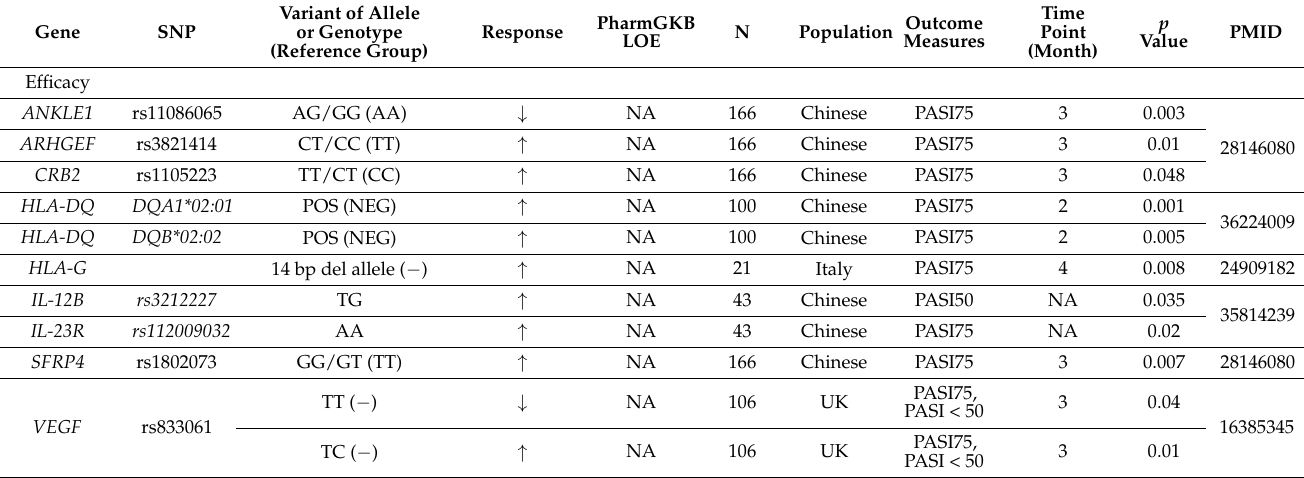
Table 2. Genetic polymorphisms associated with response of acitretin in patients with